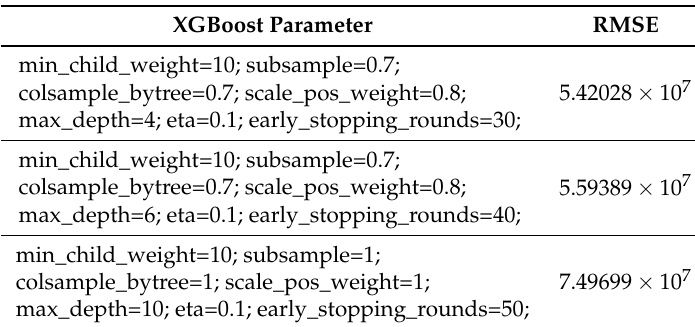
Table 2. Training